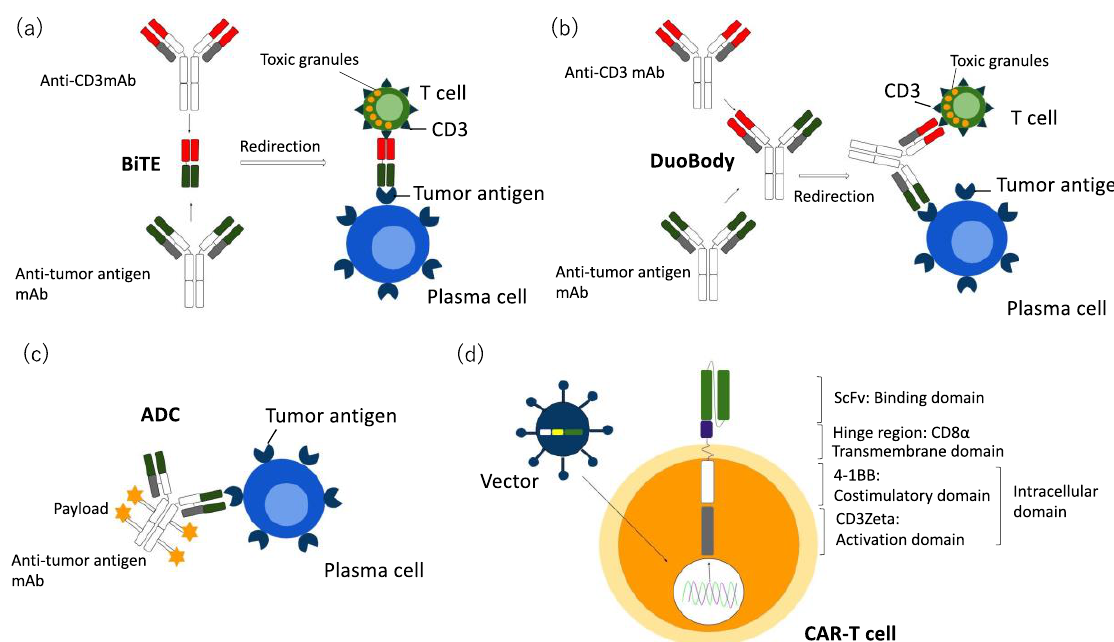
Figure 2. A diagram of structure. A bispecific antibody; ( a ) bispecific T cell engager (BiTE), ( b ) duobody construct, ( c ) an antibody-drug conjugate (ADC), and ( d ) a chimeric antigen receptor (CAR)-T cell.